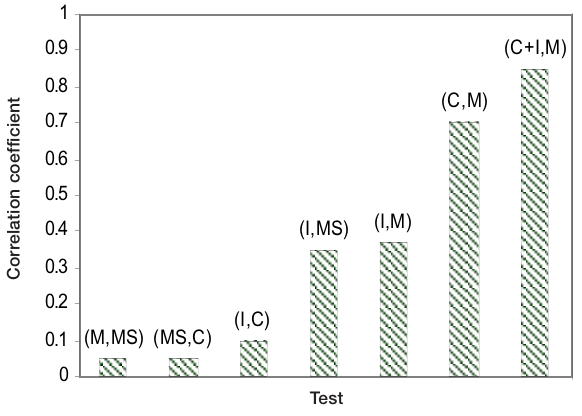
Fig. 2. Correlation between the effects of T. harzianum isolates against S. rolfsii obtained by different tests: percentage of dead sclerotia in natural soil (M), in ster- ilized soil (Ms), percentage of mycelial growth inhibi- tion in Petri dishes (I) and their saprophytic competi- tiveness